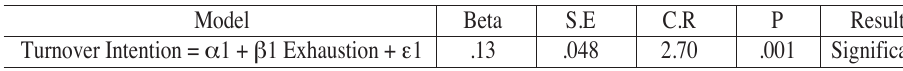
Exhaustion and Turnover Intention